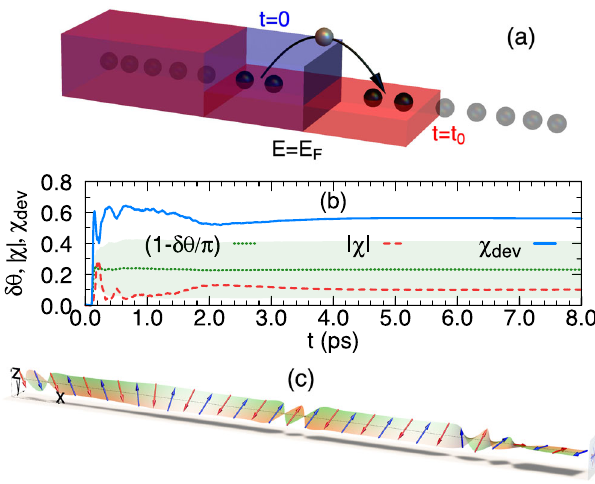
Fig. 7 Evolution of thermally initiated magnetisation dynamics. a Schematic of simulating thermal occupation. Blue and red regions show the occupation distribution at t = 0 and t = t 0 which is introduced to simulate the thermal impact of the laser. b Relative angle ( δθ ), chirality ( ∣ χ ∣ ) and chiral deviation ( χ dev ) for a speci fi c con fi guration. The shaded green region shows the root mean square deviation of δθ . The excitation takes place at 0.1ps. c End con fi guration of the evolution at 8